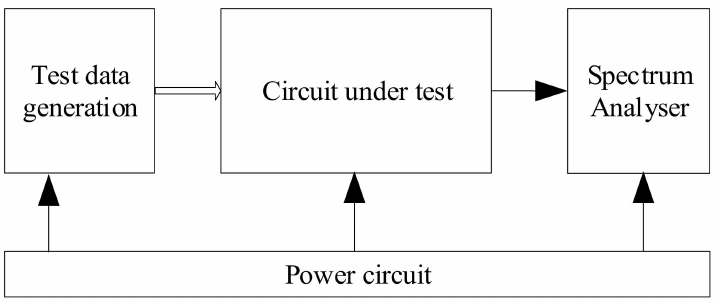
Figure 11. Block diagram of dynamic parameter SNR test.